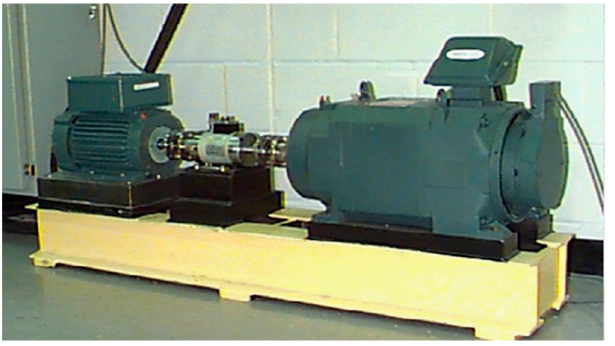
Figure 1. Experimental device.